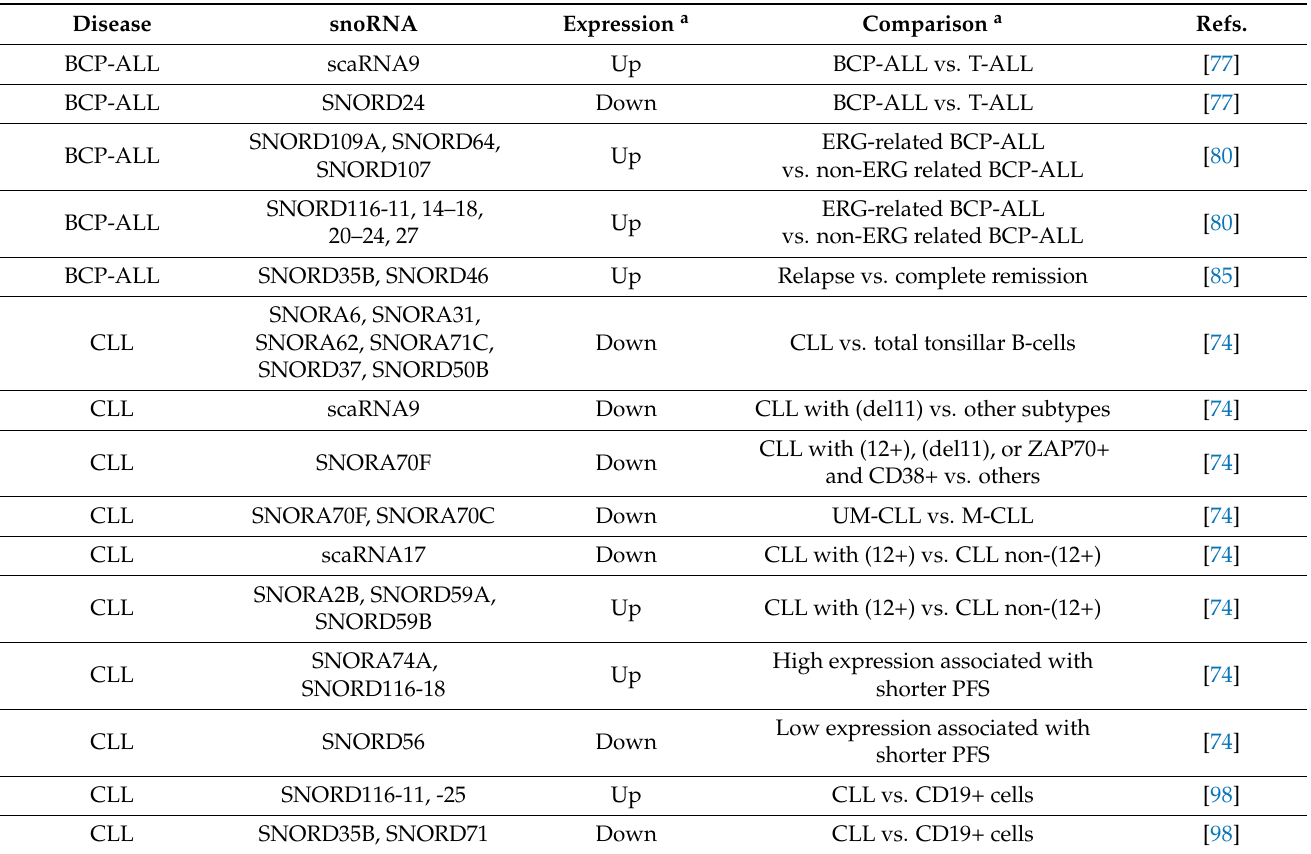
Figure 3. Involvement of snoRNA dysregulation in B-cell malignancies. Types of snoRNA dysregulation per type of B-cell malignancy are shown. Abbreviations: BCP-ALL: B-cell precursor acute lymphoblastic leukemia; CLL: chronic lymphocytic leukemia; B-NHL: B-non-Hodgkin’s lymphoma; MGUS: monoclonal gammopathy of undetermined significance; SMM: smoldering MM; MM: multiple myeloma; SNHG: snoRNA host gene. Table 1. Dysregulated snoRNAs in B-cell malignancies.